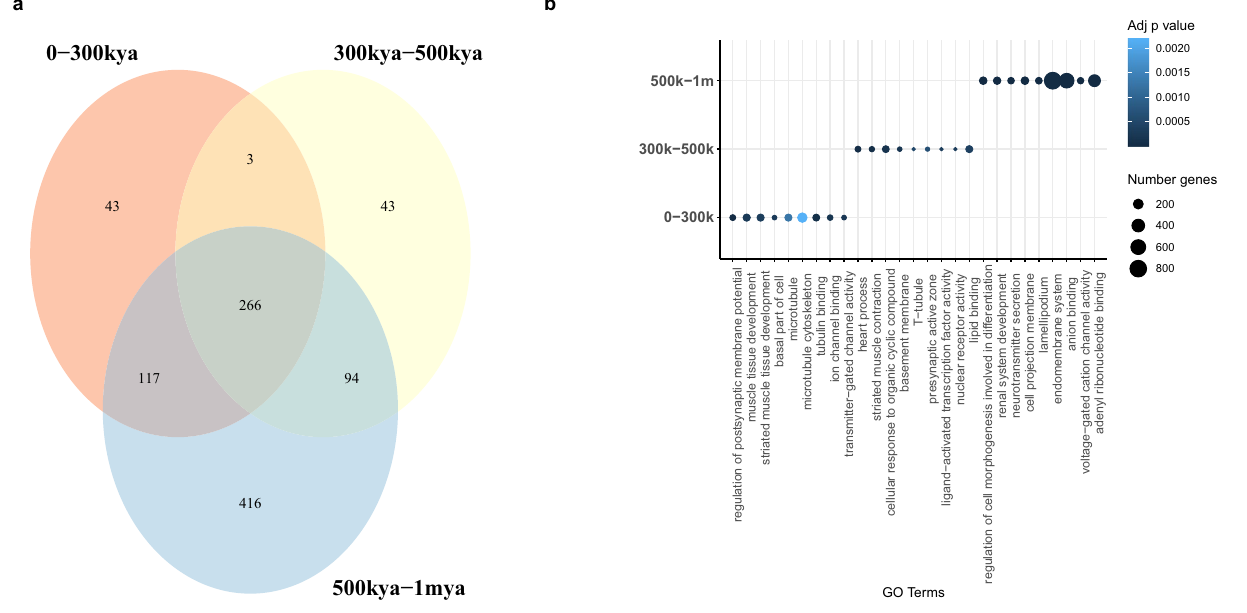
Figure 3. ( a ) Venn diagram of GO terms associated with genes shared across time windows. ( b ) Top GO terms per time